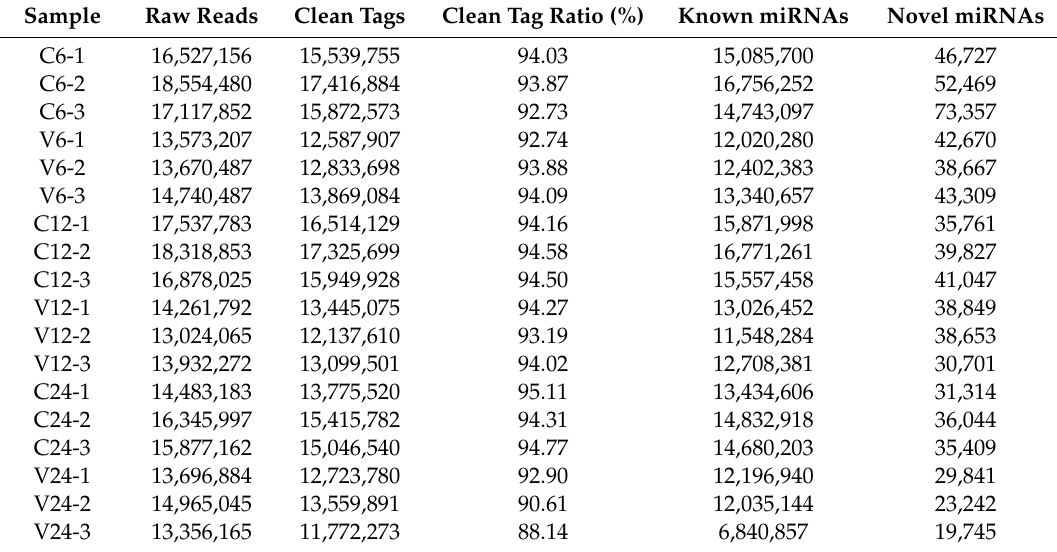
Table 1. Summary of the micro-transcriptome data of flounder infected with and without (control) Vibrio anguillarum for di ff erent